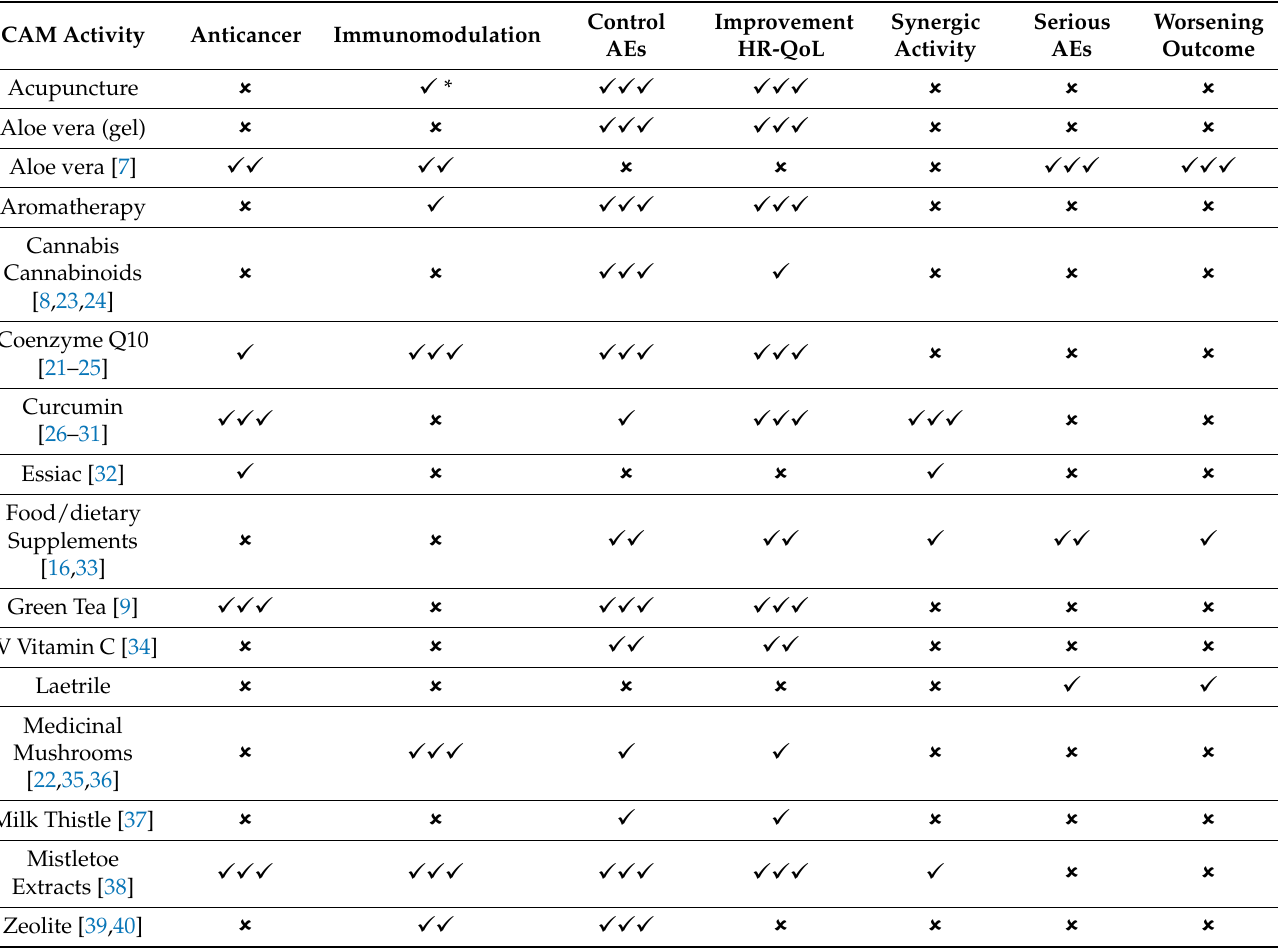
Figure 1. CAM categories.